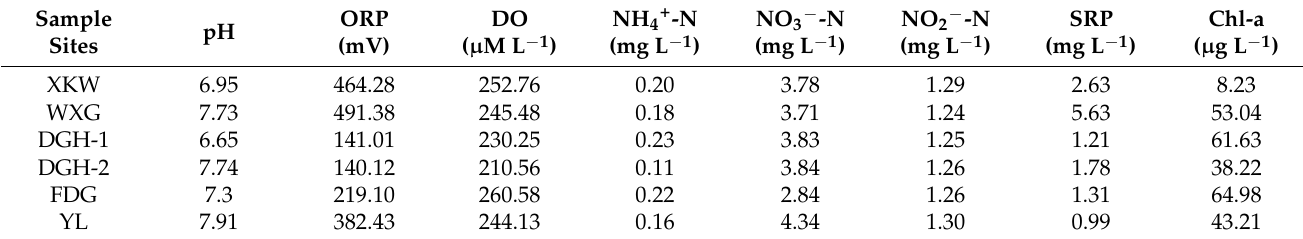
Table 1. The extent of algal bloom hazard, mean values of physicochemical characteristics of overlying water. Sample